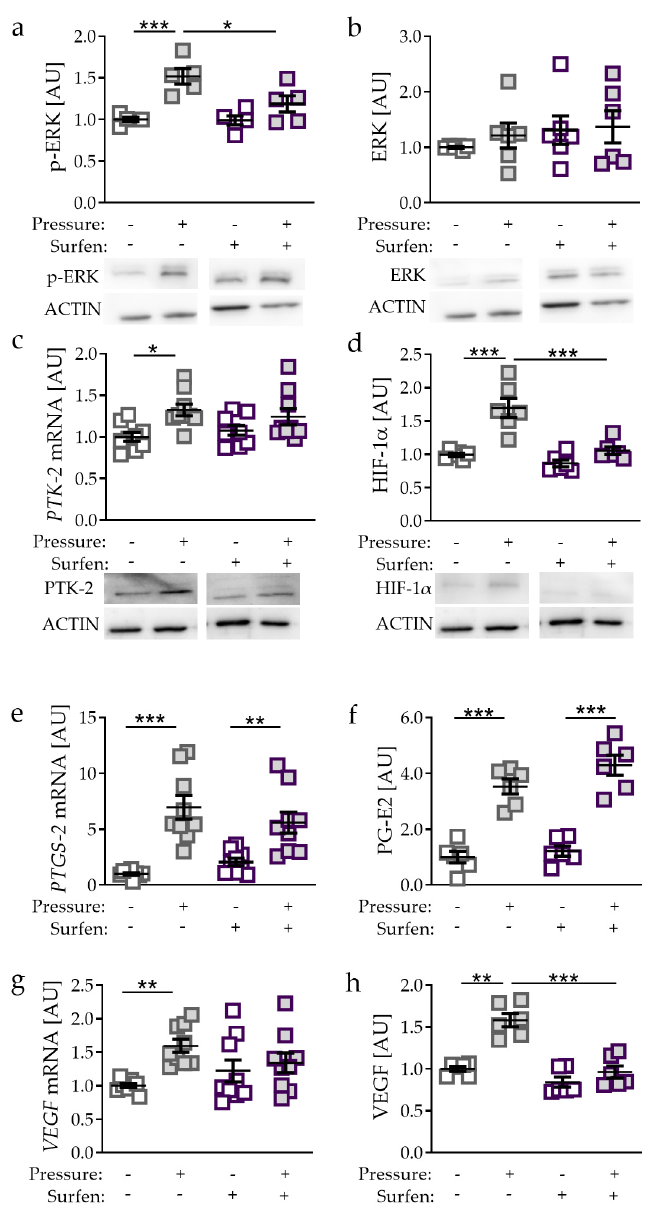
Figure 4. Effects of compressive strain with and without treatment with glycosaminoglycan antagonist surfen on p-ERK ( a ), ERK ( b ), PTK-2 ( c ), HIF-1 α ( d ), PTGS-2 /PG-E2 expression ( e , f ), and VEGF expression ( g , h ). Protein expression: n = 6; gene expression: n = 9. Statistics: ordinary one-way ANOVA followed by Holm–Sidak’s multiple comparison tests or Welch-corrected ANOVA followed by Games–Howell multiple comparison tests; AU = arbitrary units; * p < 0.05, ** p < 0.001, *** p < 0.001.